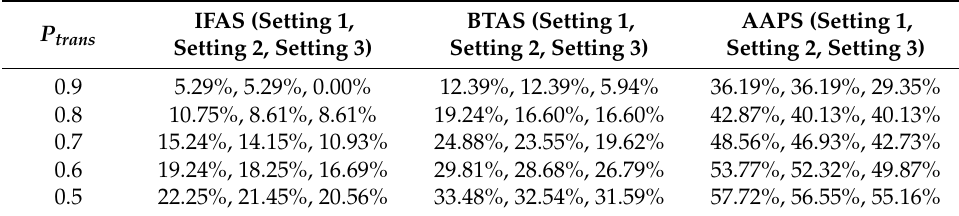
Figure 19. The average delay with P trans as variable (setting 1, setting 2, setting 3). Table 10. The improvement of delay compared with the traditional algorithm.